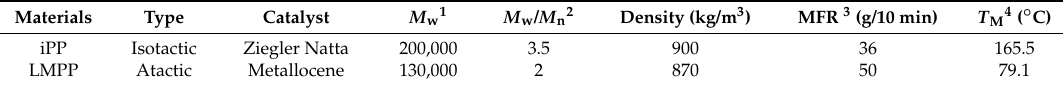
Table 1. Molecular characteristics of the iPP and LMPP